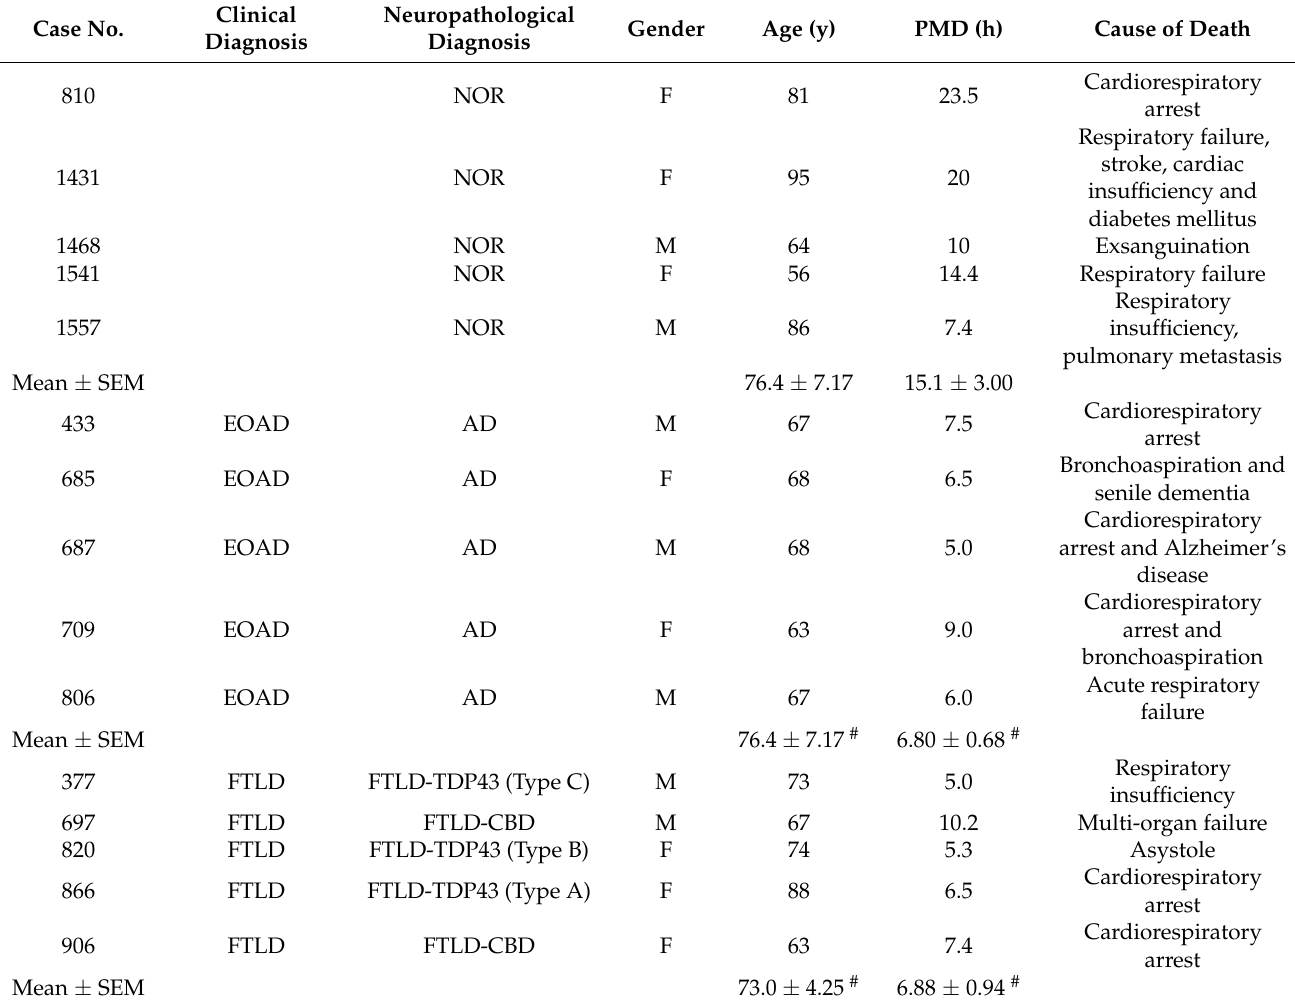
Table 1. Details of the human cases used for the